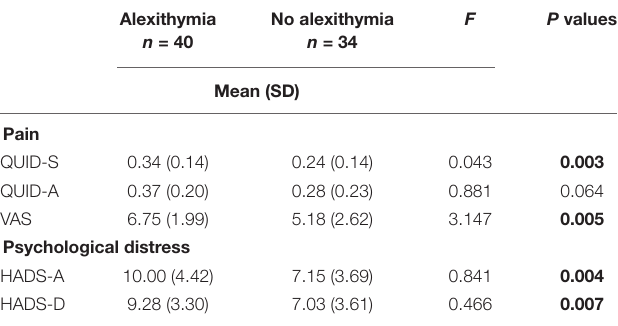
Same abbreviations as Table 2 . P values from t-test for independent